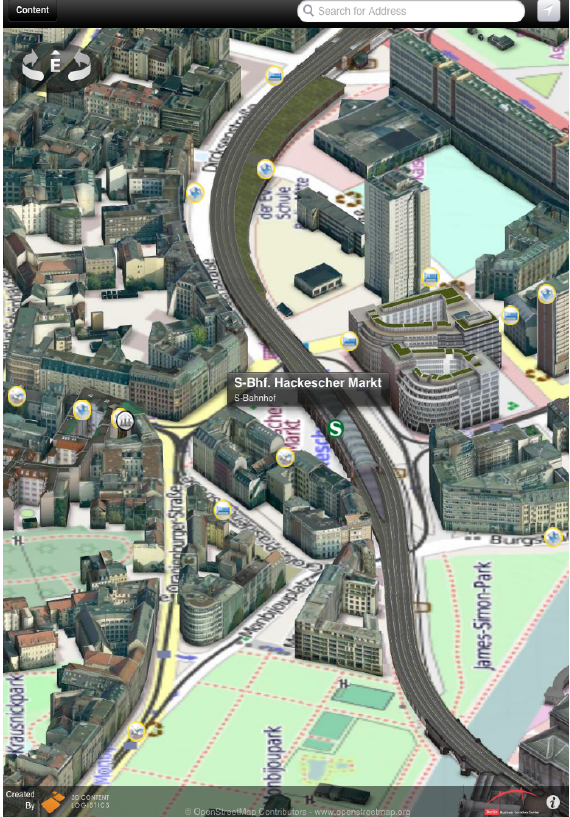
Figure 1: Screenshot of the iOS-App smartMap Berlin from our case study. The App’s user interface is kept simple: Users can use zooming and moving gestures known from 2D map interfaces.